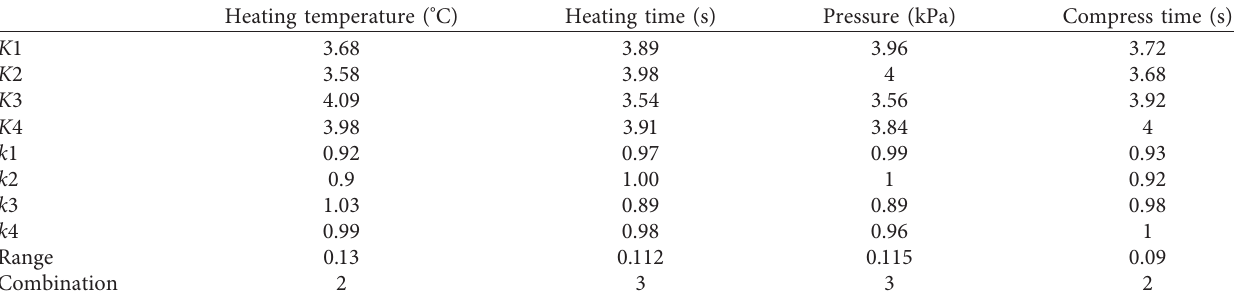
Table 5: Influence of various factors on shrinkage.